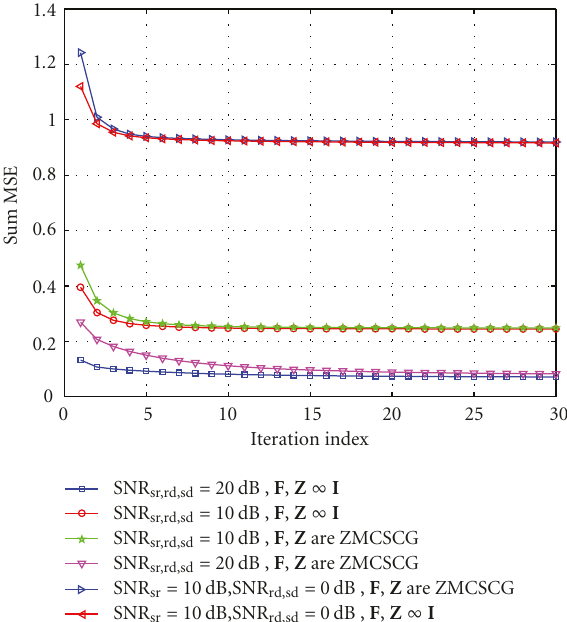
Figure 2: Convergence behaviour of the iterative approach for di ff erent initializations with the direct link ( α = 0 . 2, β = 0 . 1, σ 2 e ,1 = σ 2 e ,2 = 0 . 01, σ 2 e ,0 = 0 . 03, and P max S = P max R = 0dB).